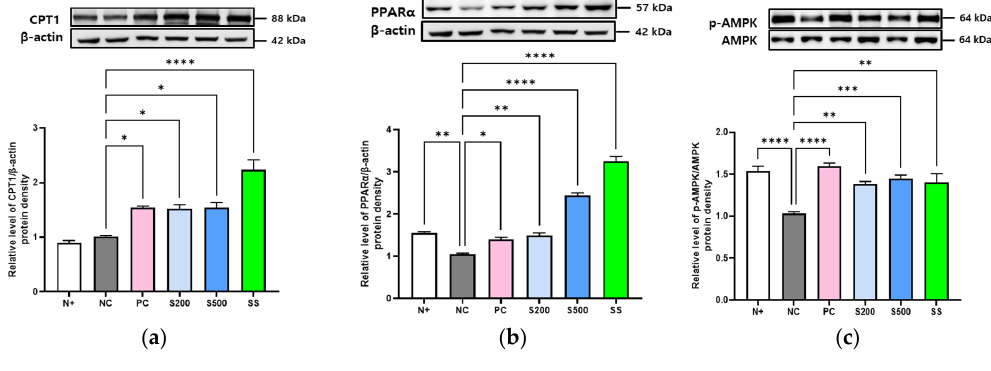
Figure 3. Stevia and stevioside activate fatty acid oxidation-related proteins in db/db mice. Mice were orally administered saline (N+ and NC), saline with 200 mg/kg/day metformin (PC), saline with 200 or 500 mg/kg/day stevia (S200 and S500), and saline with 40 mM/kg/day stevioside (SS) for 3 weeks. ( a ) Carnitine palmitoyl transferase-1 (CPT-1). ( b ) Peroxisome proliferator-activated receptor alpha (PPAR α ). ( c ) Adenosine monophosphate-activated protein kinase (AMPK). All data are presented as the mean ± SE, n = 3 and represent results from three independent experiments. * p < 0.05, ** p < 0.01, *** p < 0.001, and **** p < 0.0001.